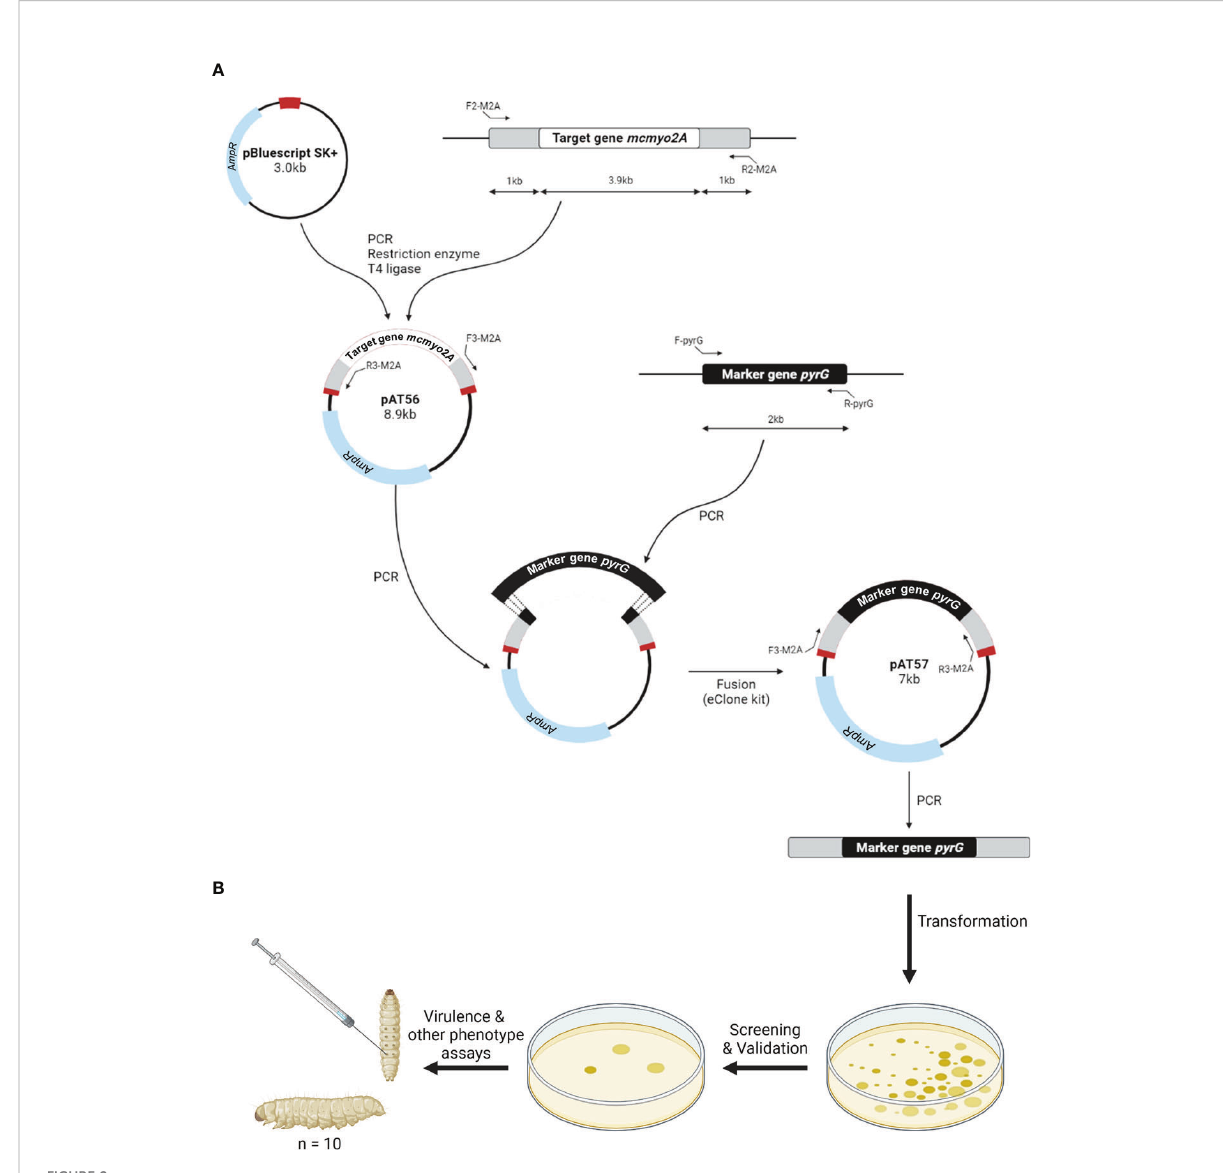
FIGURE 2 Schematic diagram of the construction of gene disruption cassettes (A) and phenotypic analyses of knockout mutants (B)